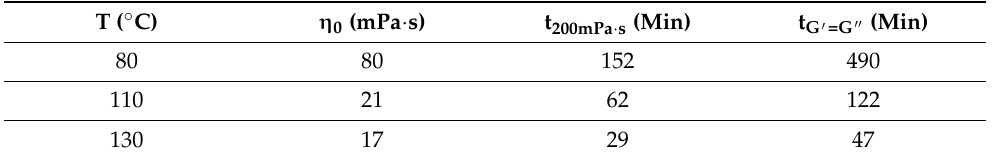
Table 4. Initial viscosity ( η 0), time to reach 200 · mPa · s, and gel time (defined as G (cid:48) = G (cid:48)(cid:48) ) at differ- ent